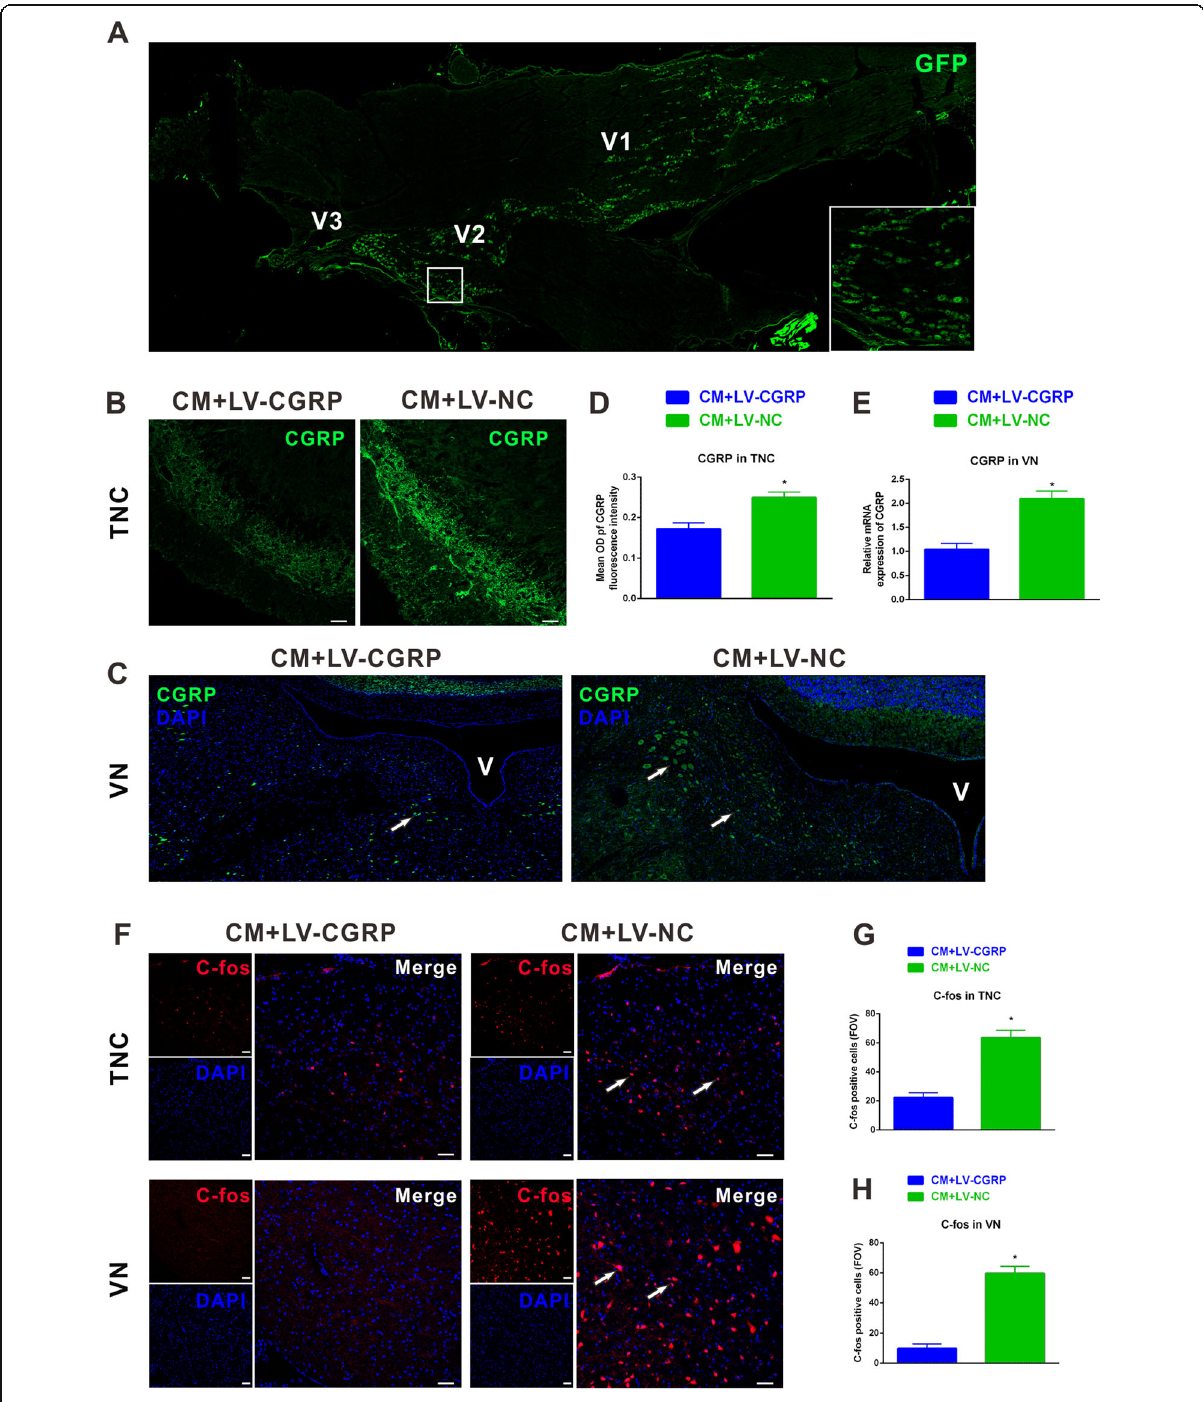
Fig. 5 Knockdown of calcitonin gene-related peptide (CGRP) in the trigeminal ganglion reduced c-fos and CGRP levels in the trigeminal nucleus caudalis (TNC) and vestibular nuclei (VN) after CM. a Representative images of immunofluorescence staining showing GFP (green) labeled lentivirus was injected into the trigeminal ganglion and dispersed in V1 and V2 branches. Representative images of immunofluorescence staining showing the immunoreactivity of CGRP in the TNC ( b ) and VN ( c ). Quantitative assessments showed that pretreatment of lentiviral vectors comprising CGRP short hairpin RNA (LV-CGRP) significantly reduced CGRP immunoreactivity in the TNC ( d ) and mRNA levels of CGRP in the VN ( e ). f Representative images showing the c-fos + neurons in the TNC and VN. ( g ) In the LV-CGRP treated group, the number of c-fos positively stained neurons in the TNC and VN significantly reduced compared with blank lentiviral vectors (LV-NC). FOV = 1.02 × 10 6 μ m 3 . b , f Scale bar = 50 μ m; * P < 0.05 compared with vehicle, n = 8/group. Data are mean ± SEM. Student ’ s t